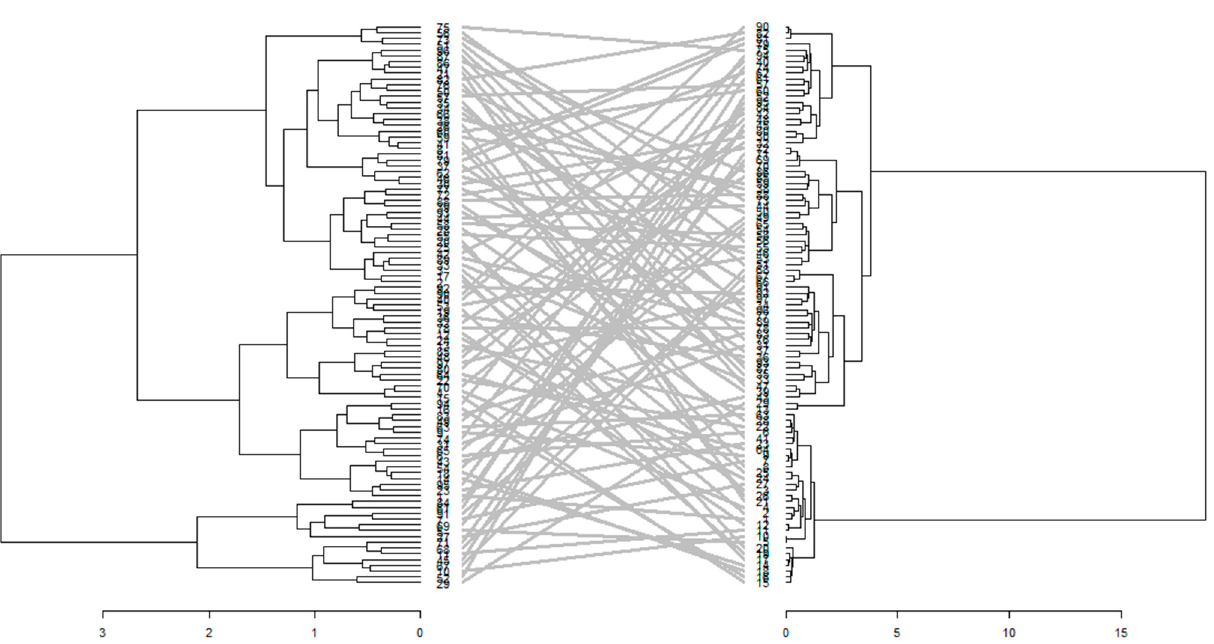
Figure 4. Tanglegram comparison of genotypic and phenotypic hierarchical clusters of 97 wheat genotypes based on 16,382 SNP markers and phenotypic data measured under non-stressed conditions.